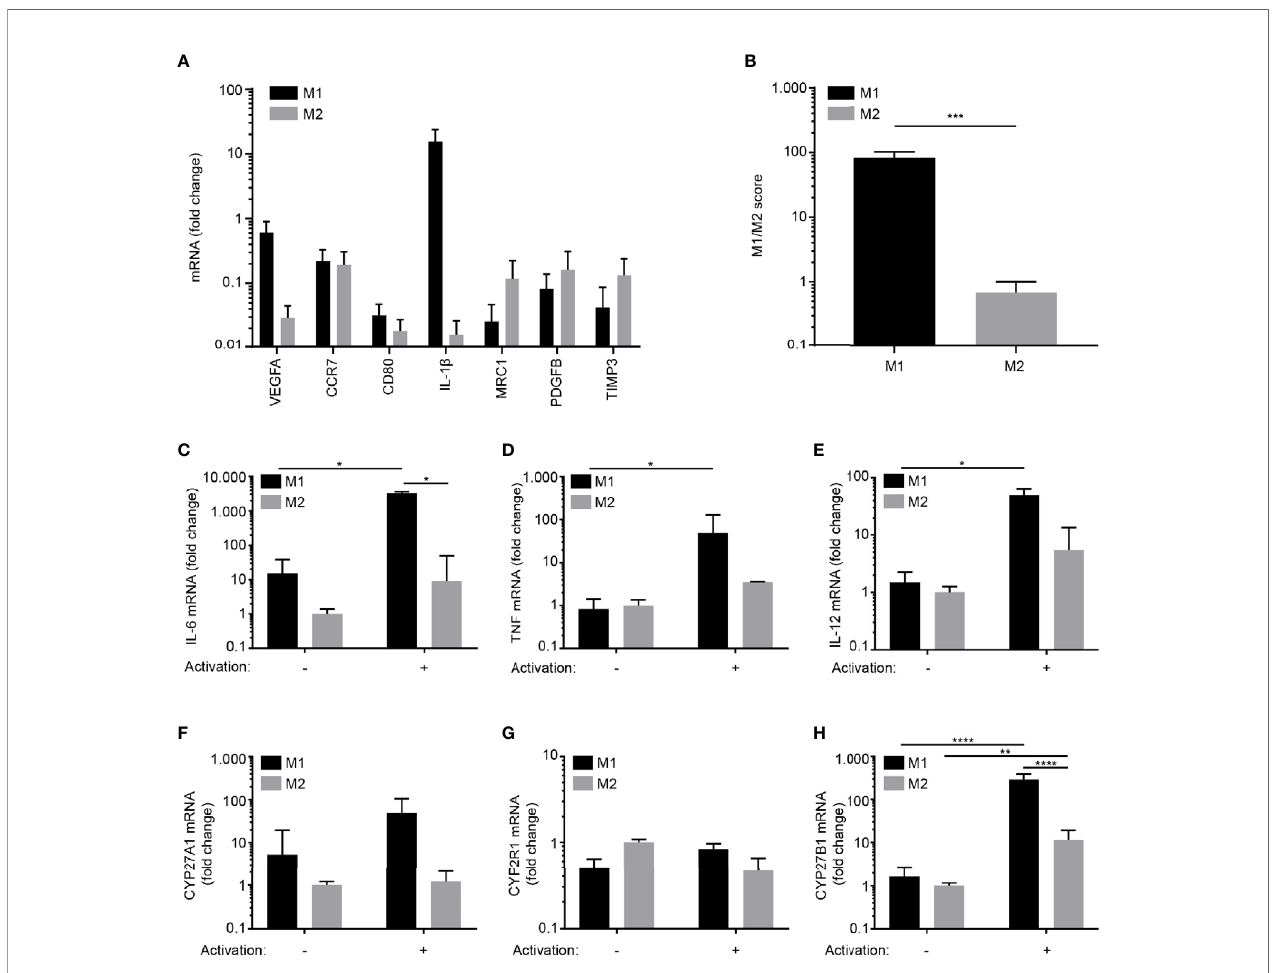
FIGURE 1 | Differentiation of human monocyte-derived M1 and M2 macrophages in vitro . (A) Relative mRNA expression of M1 (VEGF, CCR7, CD80 and IL-1 b ) and M2 signature markers (MRC1, PDGFB and TIMP3) in M1 and M2 macrophages activated with LPS and IFN g and LPS, respectively. (B) M1/M2 score in activated M1 and M2 macrophages. Data (mean + SEM) were obtained from two independent experiments with four donors and tested by two-tailed, paired Student ’ s t-tests. Relative mRNA expression of (C) IL-6, (D) TNF, (E) IL-12A, (F) CYP27A1 (G) CYP2R1and (H) CYP27B1 in resting and activated M1 and M2 macrophages. The data in (C – H) are normalized to the values obtained from non-stimulated M2 macrophages. Data (mean + SEM) were obtained from three independent experiments with fi ve donors and tested by one-way ANOVA with post hoc multiple comparisons test (Tukey ’